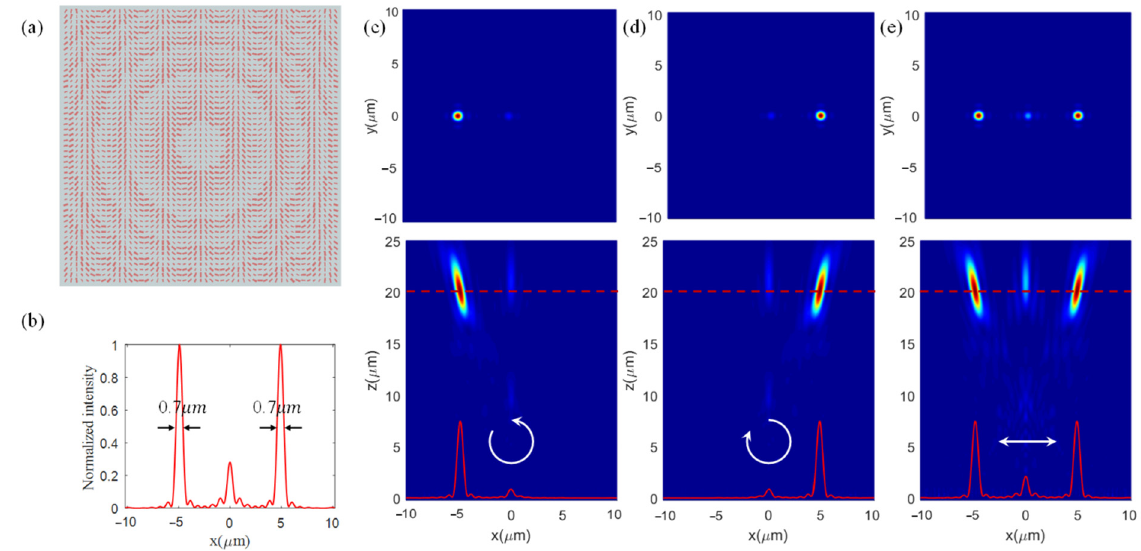
Figure 5. Simulation for the orthogonal circular polarization multiplexing metalens. ( a ) Top view of this designed metalens. ( b ) The sectional intensity profile along the x-axis in the focal plane. Intensity maps in the xy-plane and xz-plane under ( c ) LCP, ( d ) RCP, and ( e ) x-linearly polarized light incidences.